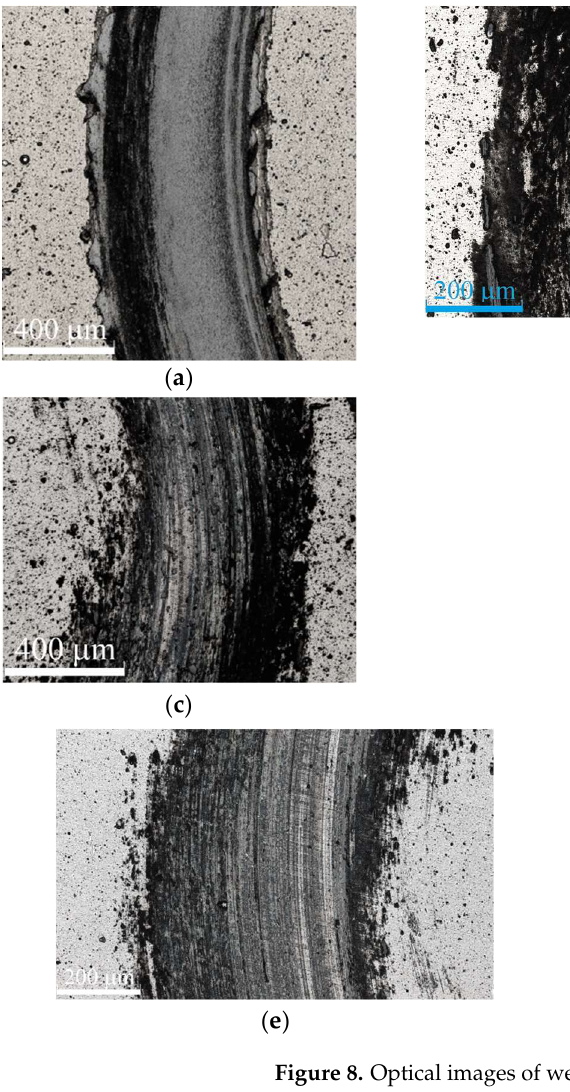
( f ) Figure 7. The wear scar images on steel balls rubbed against ZrN ( a ), CrN ( b ), ZrCrN(0.5) ( c ),